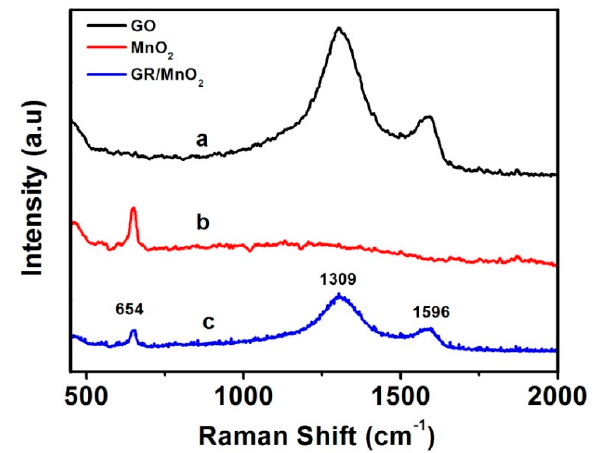
Figure 3. Raman spectra (a) GO, (b) MnO 2 and (c) MnO 2 -GR nanocomposite.